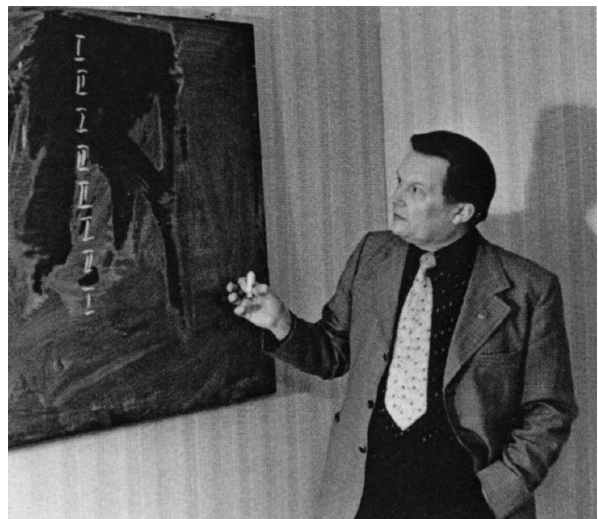
Figure 3. Eero Kataja lecturing at the Meteorological Observatory of Nurmijärvi in the 1970s (photo supplied by